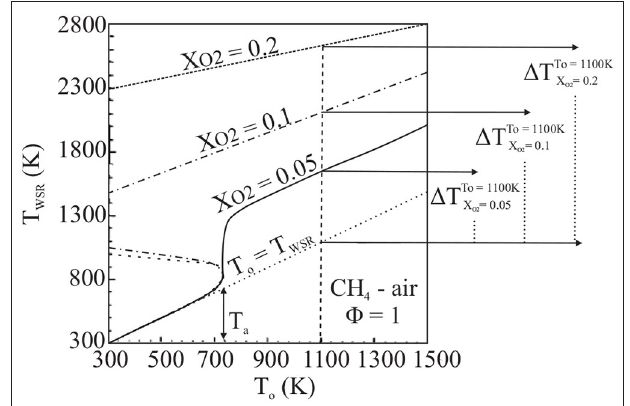
FIGURE 1 | WSR behavior as a function of dilution ( X O 2 ) demonstrating conventional folded ( X O 2 = 0.1,0.2) and smooth (MILD condition, X O 2 = 0.05) S-Shaped Curves, from Cavaliere and de Joannon